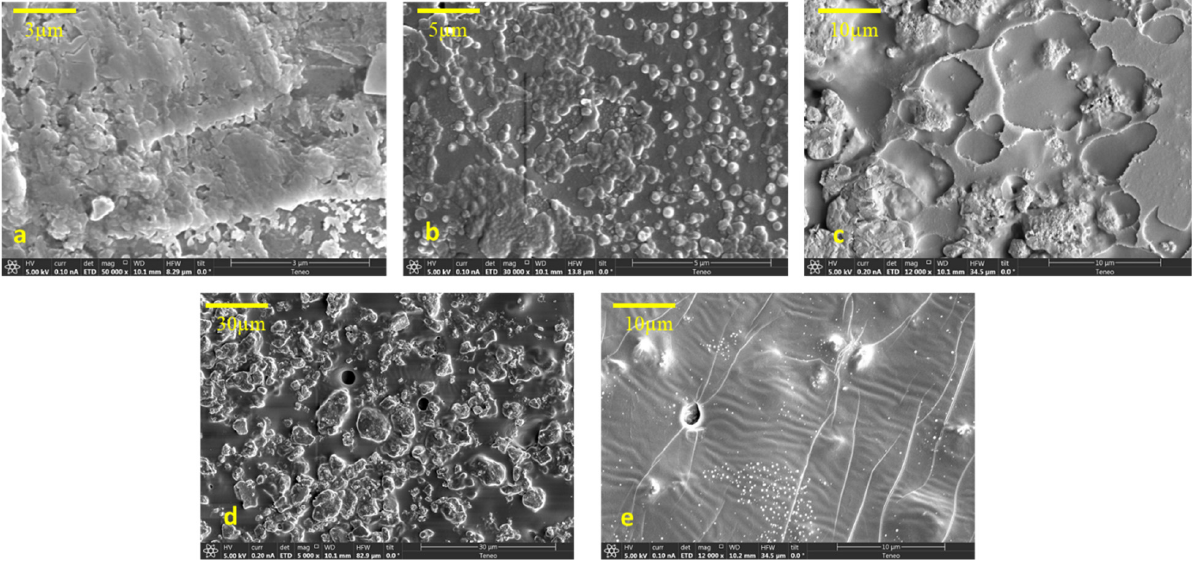
Figure 3. SEM images for ( a ) C-PMMA (50,000×), ( b ) C-PMMA/SnO 2a (30,000×), ( c ) C-PMMA/SnO 2b (12,000×), ( d ) C-PMMA/SnO 2c (5000×), and ( e ) C-PMMA/SnO 2d (12,000×).